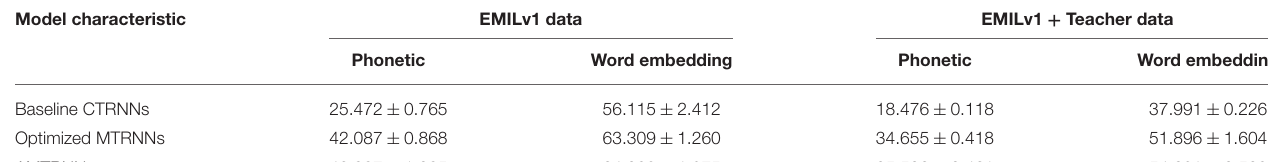
TABLE 1 | Test accuracy (%) for different CTRNN architectures on phonetic vs. word representation.